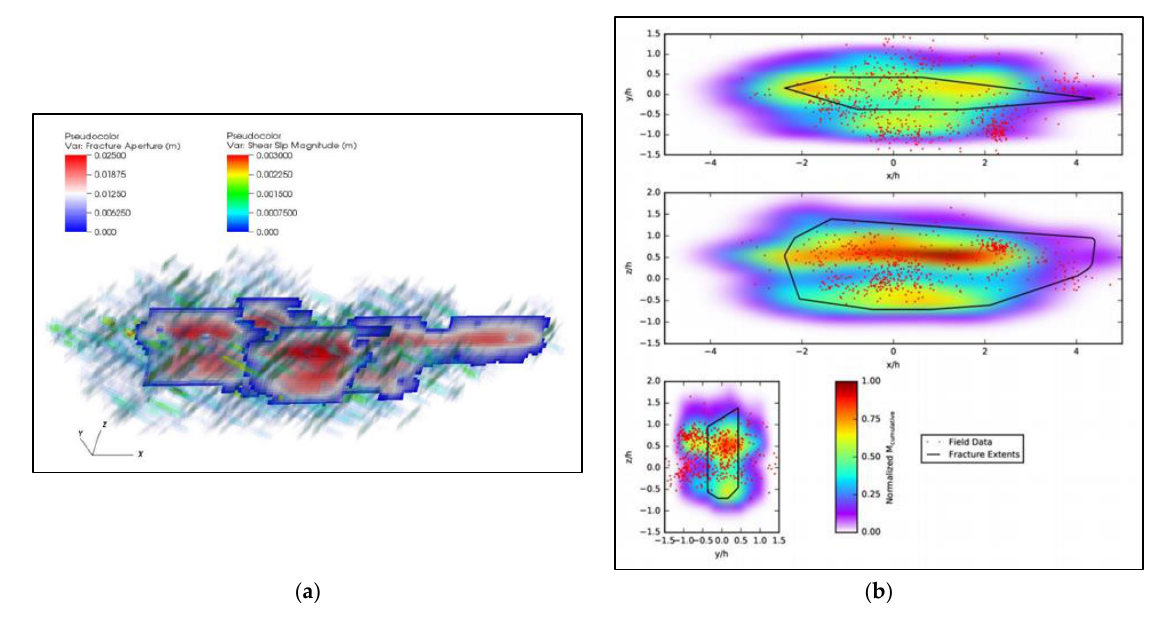
Figure 10. Examples of synthetic microseismic events using a high-fidelity simulator. ( a ) Hydraulic fractures propagating in naturally fractured rock; ( b ) associated microseismic events (modified after [30]).